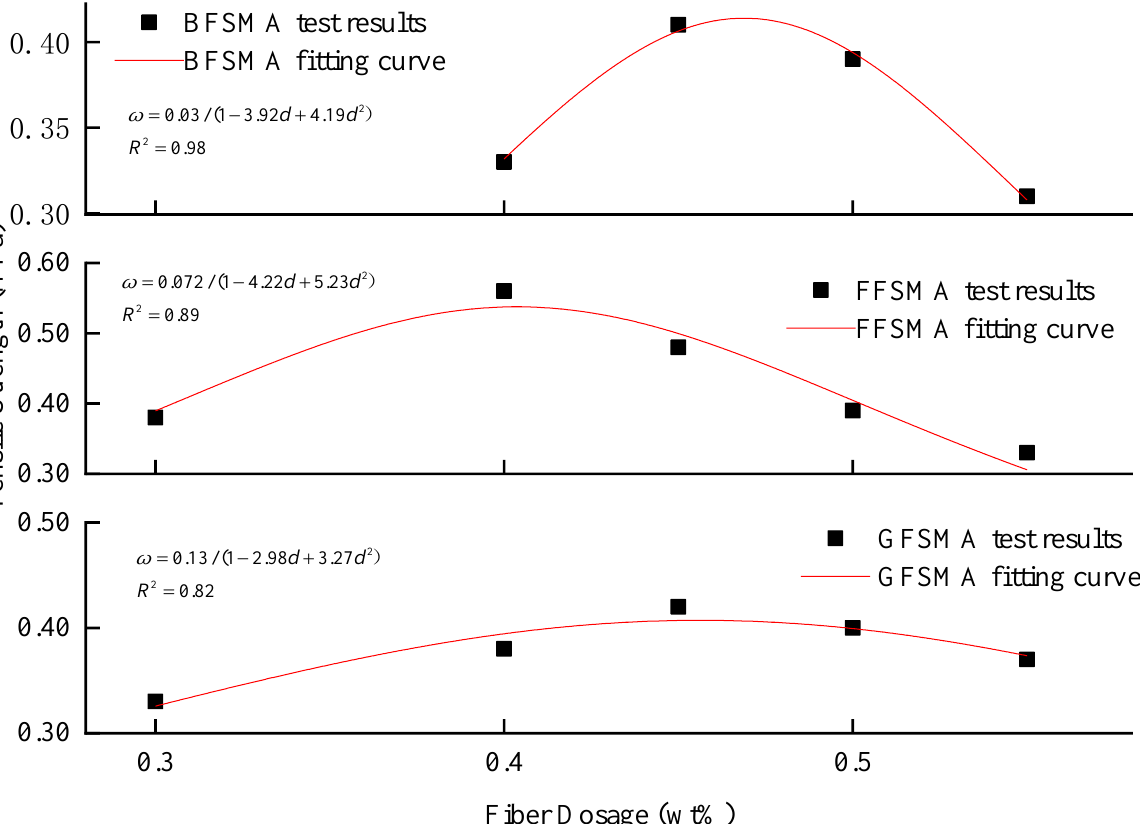
Figure 6. Fitting between fiber dosage and tensile strength.